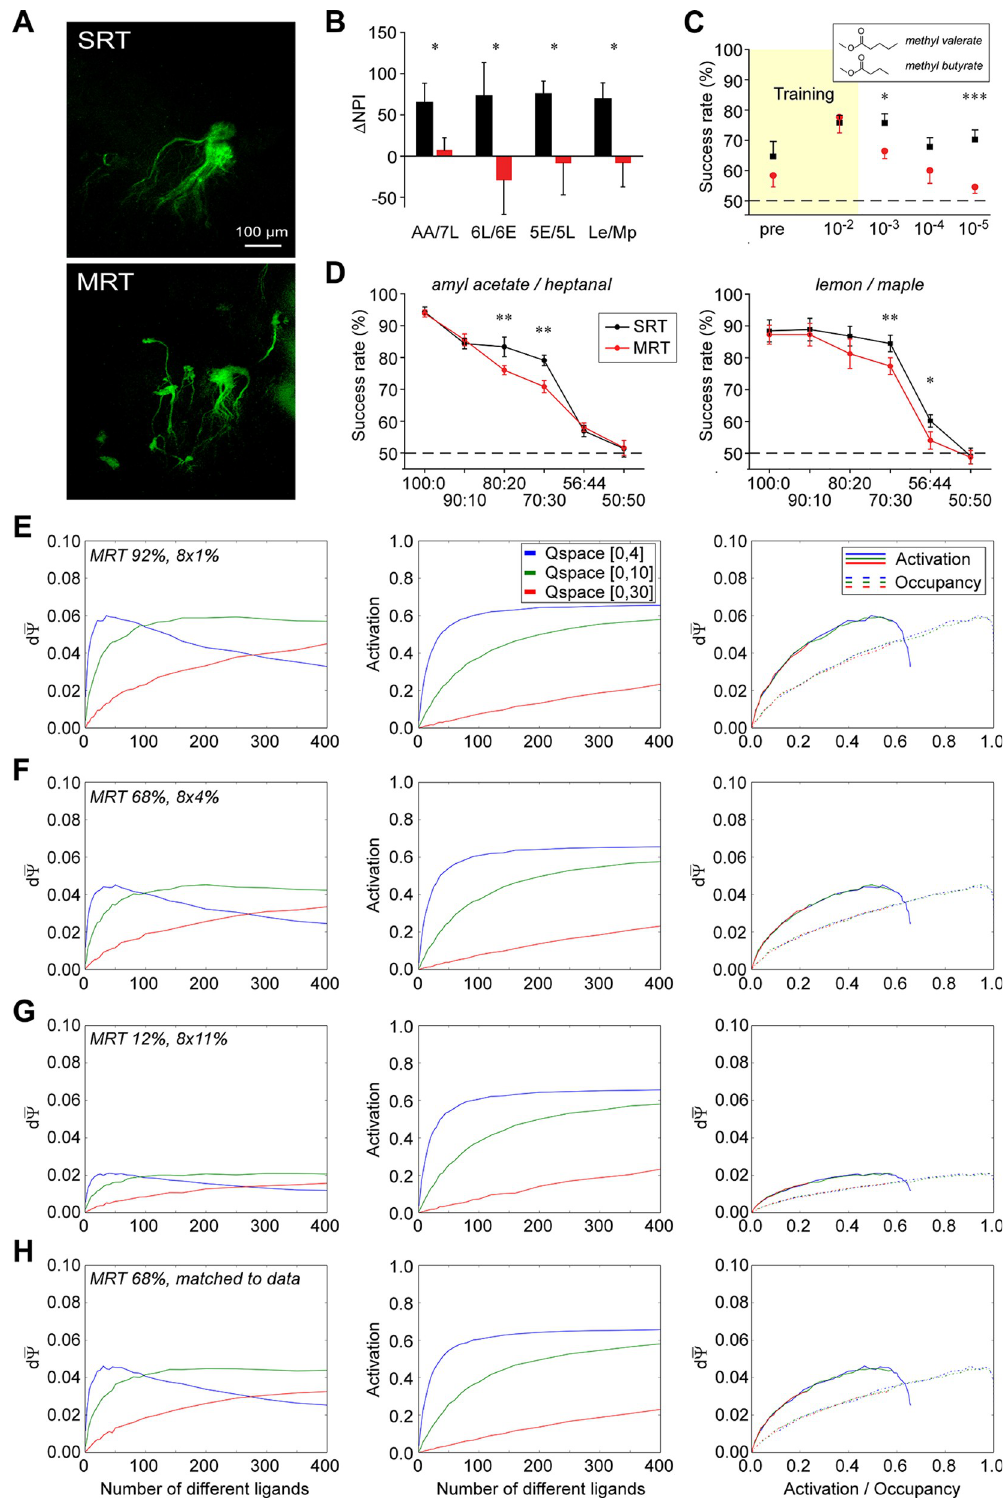
Fig 8. Effects of multi-receptor convergence onto common glomeruli. In contrast to wildtype (SRT) mice, in which each glomerulus is targeted only by one type of receptor, MRT transgenic mice exhibit glomeruli that are targeted by multiple receptor types. In the model, whereas each glomerulus still was predominantly targeted by a single corresponding receptor type, eight other receptor types also contributed smaller inputs. Mean occupancy, activation and discrimination capacity functions were calculated for glomeruli as weighted averages of those exhibited by their constituent receptors. A. Whole